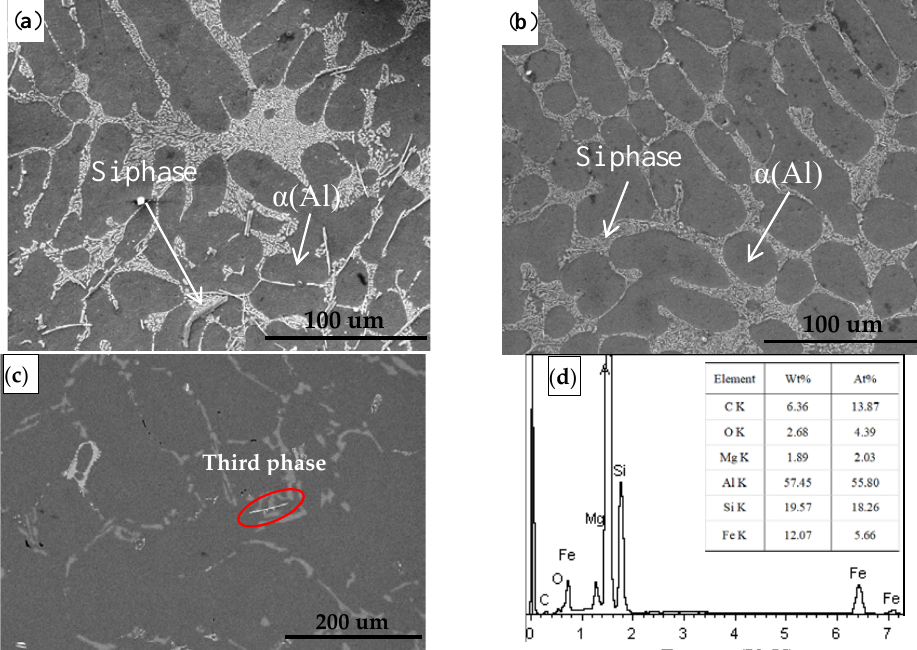
Figure 7. SEM image and XRD image of vacuum counter-pressure casting aluminum alloy samples without UST and with UST; ( a ) 350kPa solidification pressure, ( b ) Synergistic action of 600W ultrasonic power and 350kPa solidification pressure, ( c ) SEM image in BSE under 350 kPa solidification pressure, ( d ) Energy spectrum analysis of third phase.